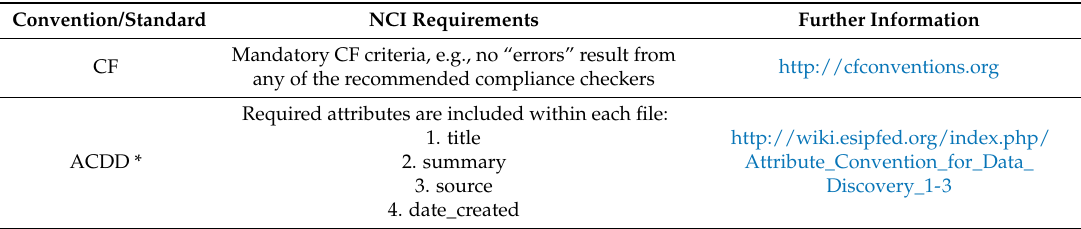
Table 1. The NCI Quality Control (QC) mandatory requirements. A full list of the Attribute Convention for Data Discovery (ACDD) metadata requirements used by NCI is provided in Appendix